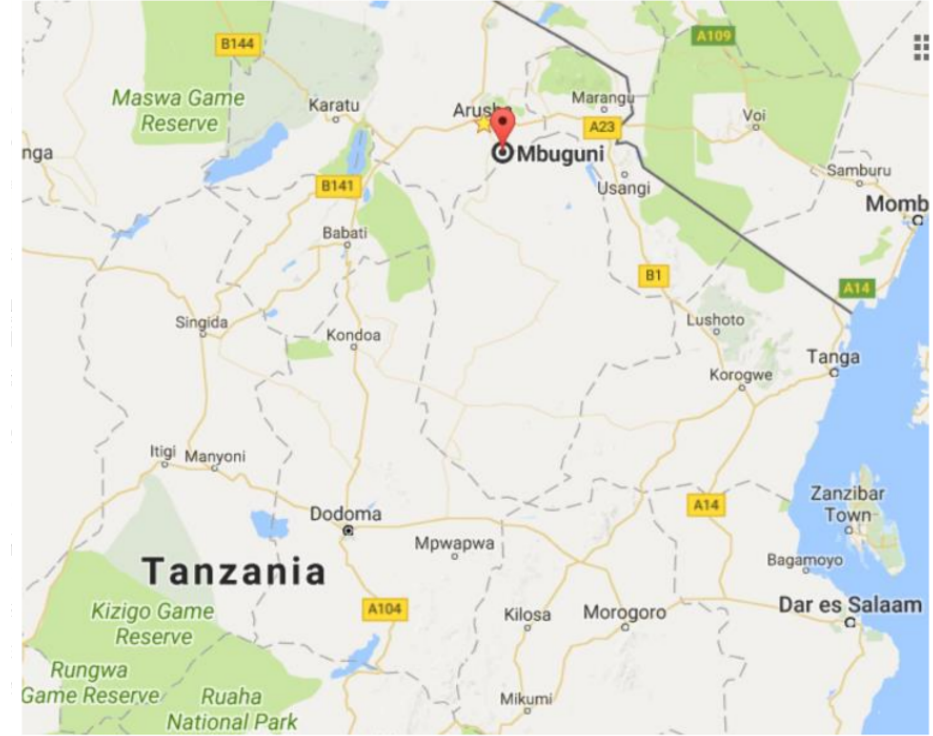
Figure 4. Geographical position of the proposed site at Mbuguni, Arusha Tanzania (Latitude 3 degrees 34 min South: Longitude 36 degrees 57 min